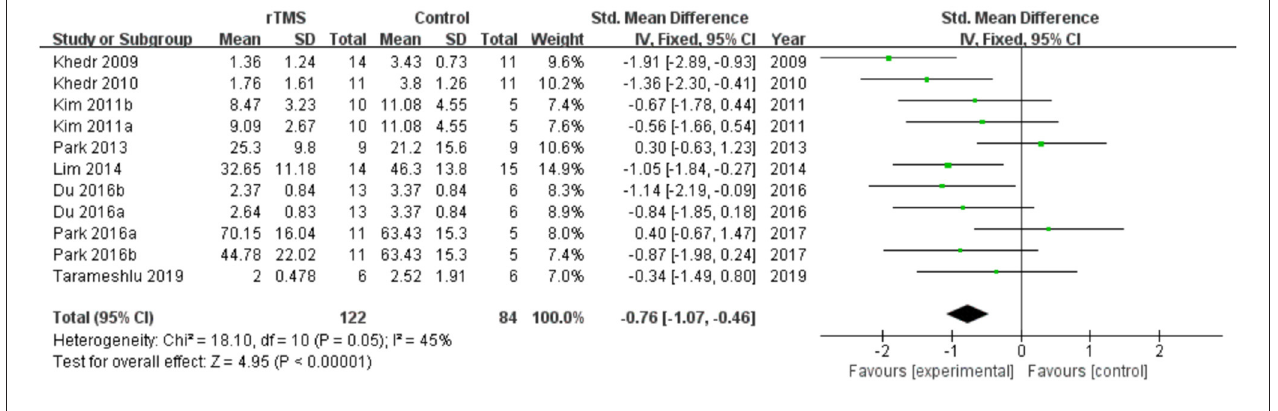
FIGURE 4 | Forest plot for overall swallowing function.